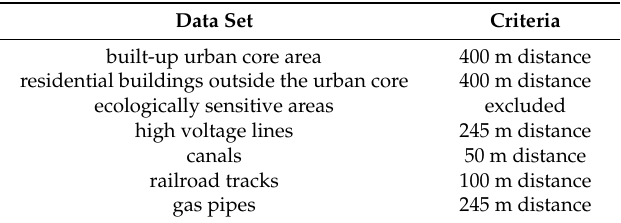
Table 3. Criteria applied for the demarcation of the suitable wind area.